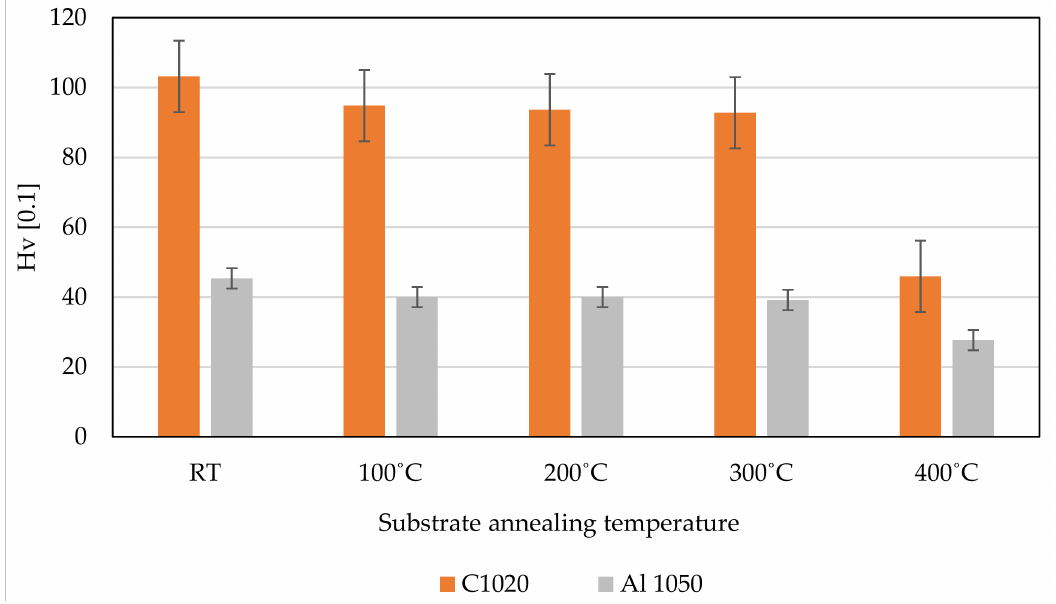
Figure 10. Heat-treated pure metal hardness of both pure materials from RT to 400 ◦